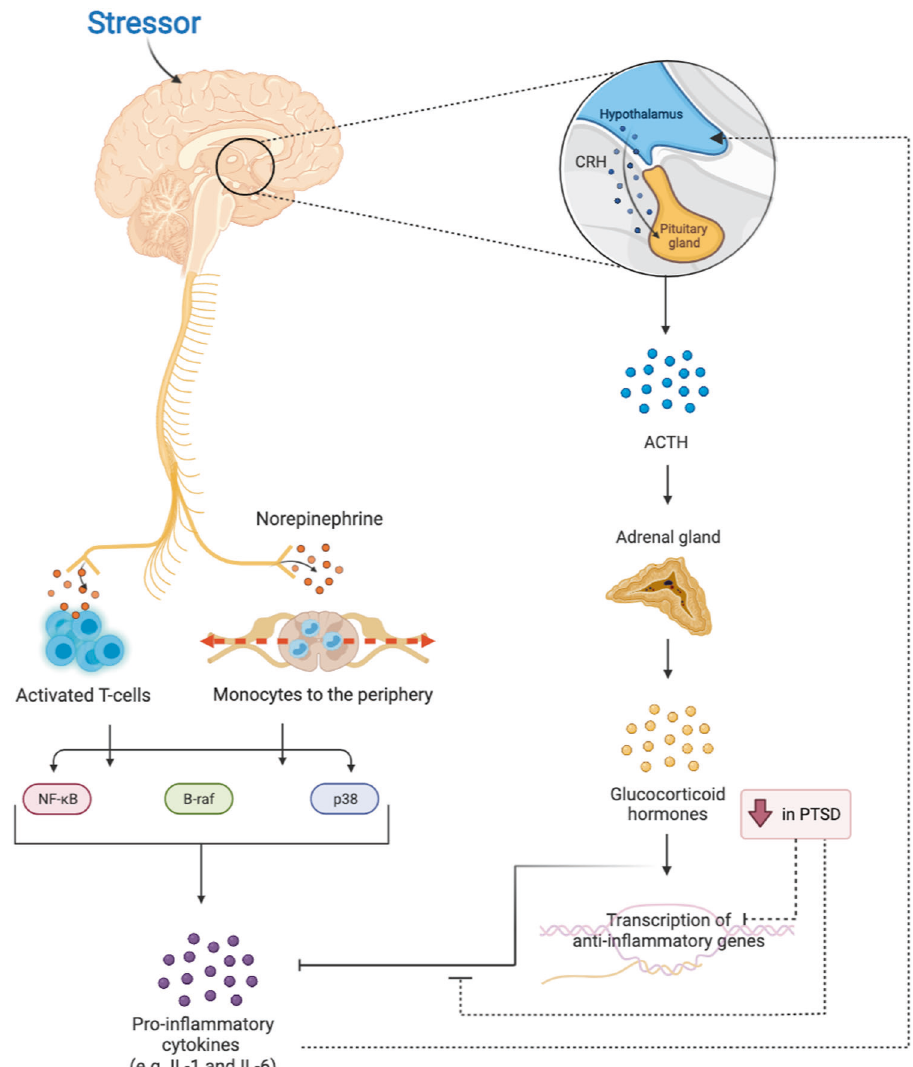
Fig. 2 Relationship between the HPA axis, sympathetic nervous system, and in fl ammation in PTSD. Stress exposure stimulates sympathetic nervous system (SNS). Norepinephrine release from activated SNS fi bers stimulates proin fl ammatory cytokines production through the NF-kB, B-Raf, and p38 pathways. The HPA axis is also activated upon exposure to stress, stimulating in fl ammatory responses that limit HPA reactivity. The reduced ability of glucocorticoids to inhibit in fl ammatory processes contributes to the proin fl ammatory environment in PTSD. CRH corticotrophin-releasing hormone, ACTH adrenocorticotropic hormone, NF- κ B nuclear factor- κ B, IL-1 Interleukin-1, IL-6